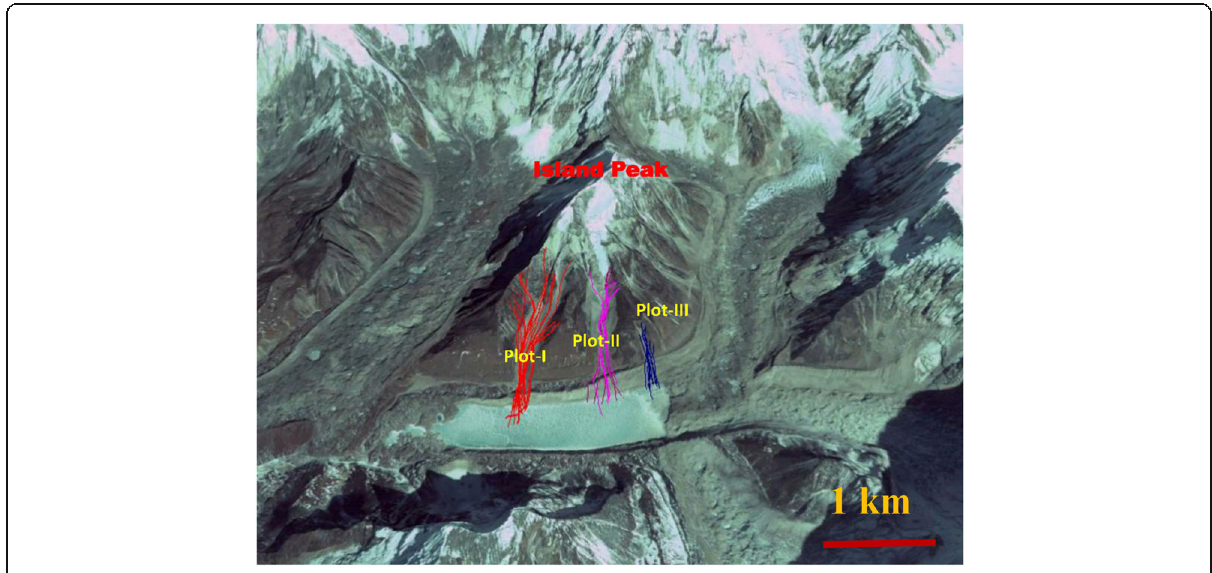
Fig. 5 Three plots (source of rockfall) identified on Google Earth Image